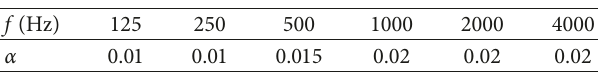
Table 3: Sound absorption of the slab track (nominal values).